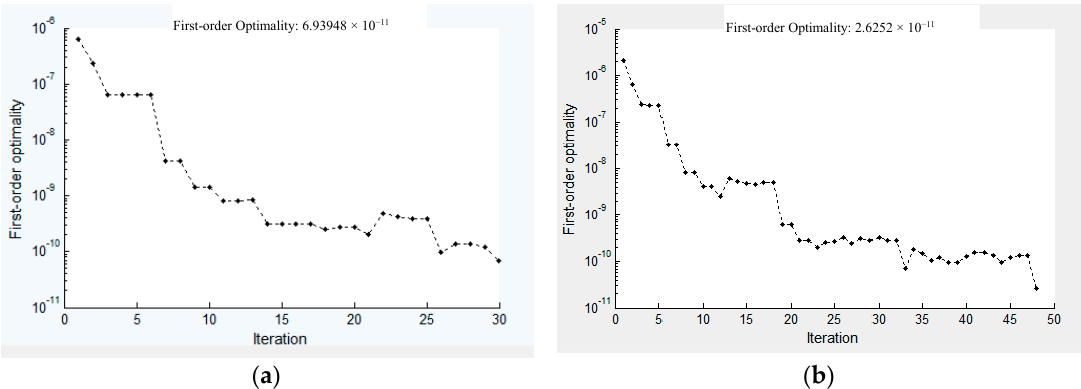
Figure 12. First-order optimality of the last step of the zero path tracking. ( a ) 50 steps uniformly; ( b ) 50 steps periodic.